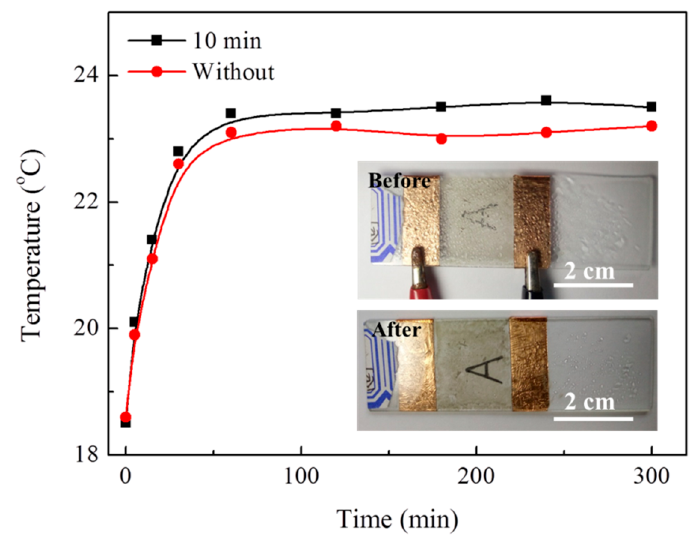
Figure 5. Temperature increase curves of Ag nanowire-based film heaters; inset images are the optical photograph of the defogging process on the Ag nanowires based film heater.